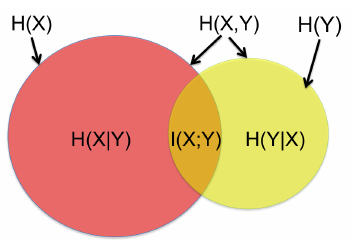
Figure 2. Venn diagram of entropy properties. The area covered by red and orange is the entropy of X , H(X) , whilst the area covered by yellow and orange represents the entropy of Y , H(Y) . The red area is the conditional entropy of X given by Y , H(X | Y) , whereas the yellow area is the conditional entropy of Y given by X , H(Y | X) . The area contained by both circles is the joint entropy H(X,Y) and the orange area is the mutual information between X and Y , I(X ; Y)